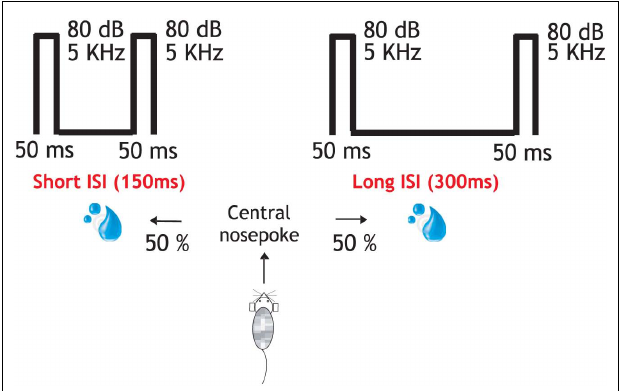
FIGURE 1 | Behavioral protocol and performance. In the attentive task the rat entered in the central socket and two identical stimuli (50ms; 80dB; 5322Hz) were presented through earphones. About 150 or 300ms interstimulus interval indicated left or right reward delivery, respectively. These same stimuli (interstimulus interval (150 and 300ms), intertrial interval (2–3s), and trial repetitions (180) were delivered under different stages: “Initial passive,” attentive, “passive post” identical to the “initial passive” one and another passive recording but now followed by a reward after each pair of stimuli presentation.The total duration of the recording protocol was